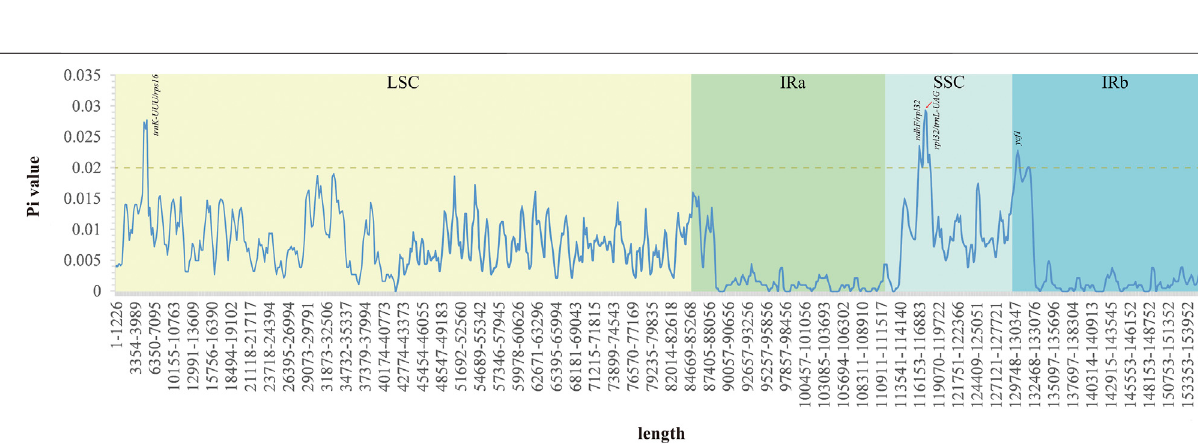
Frontiers in Genetics |